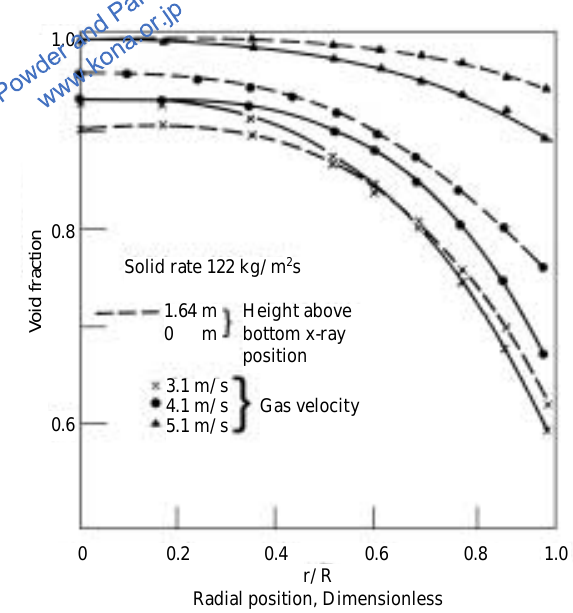
Fig. 10 Radial variation of void fraction, constant solids rate